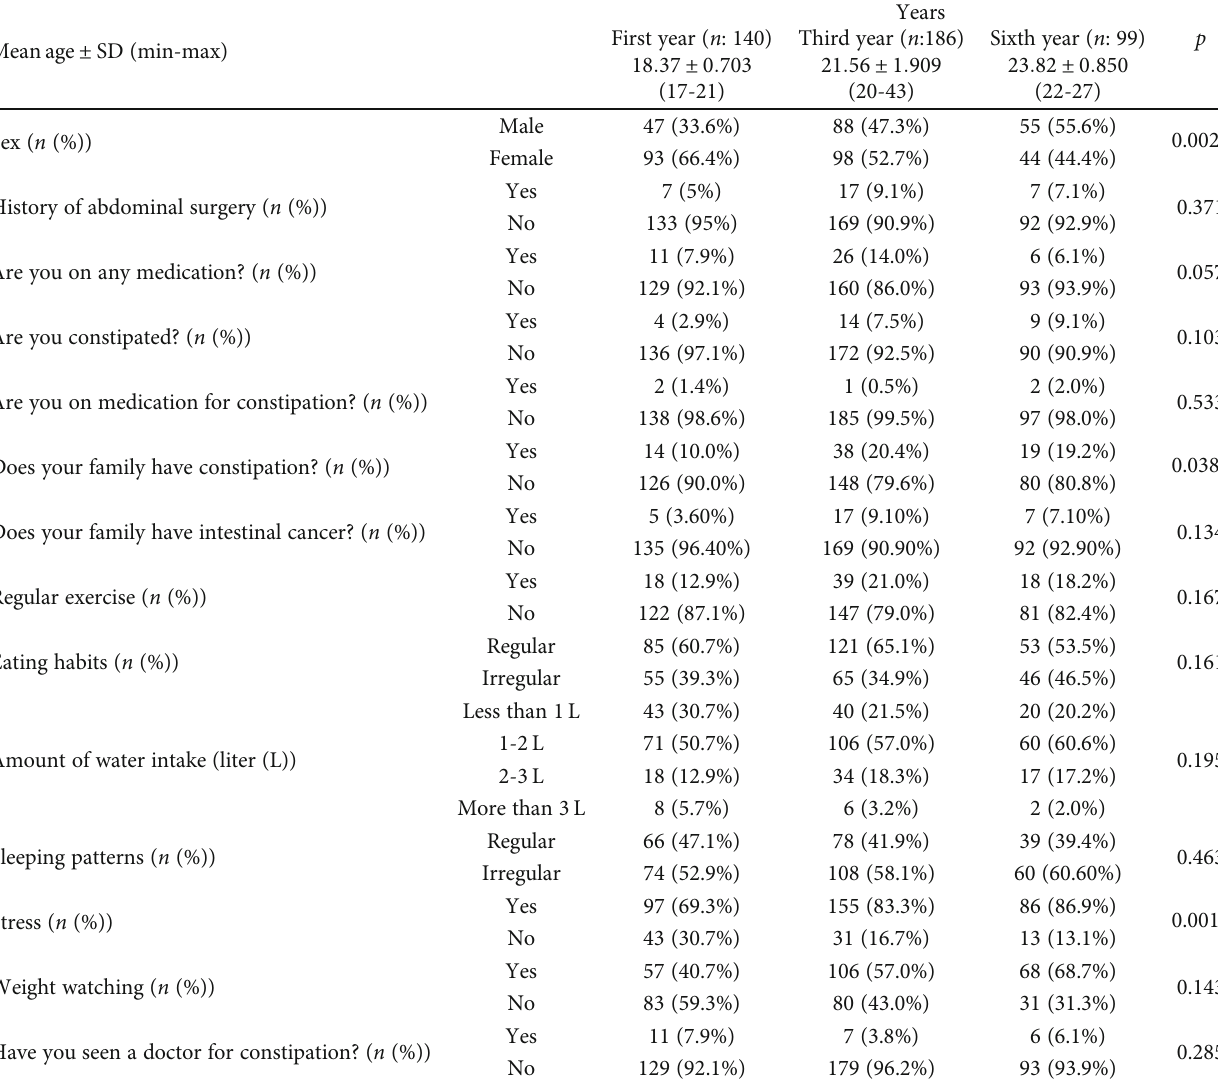
Table 1: Demographic